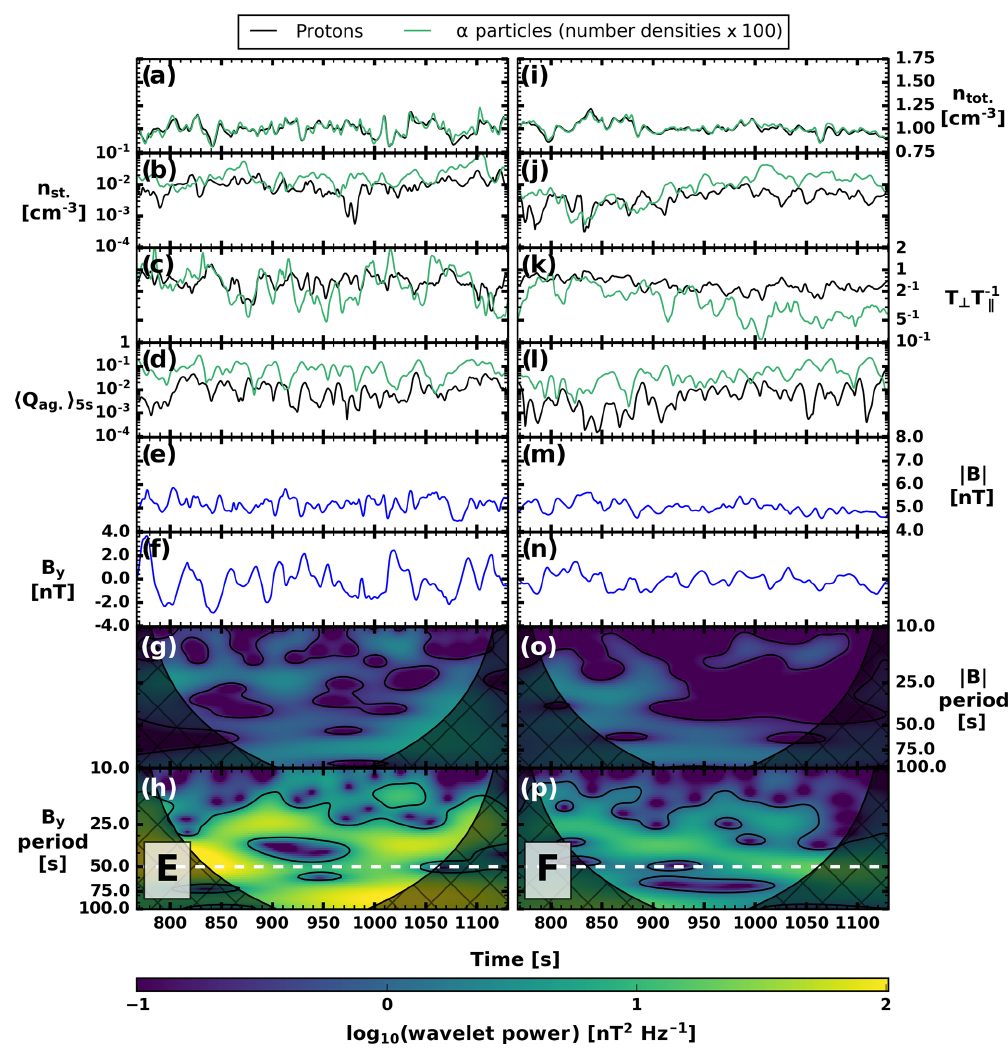
Figure 10. Time series and wavelets at virtual spacecraft positions E (a–h) and F (i–p) in the ULF foreshock. Panels (a–d) and (i–l) show proton (helium) quantities in black (green). (a, i) Total number densities. (b, j) Suprathermal number densities on a logarithmic scale. (a, b, i, and j) The helium number densities have been multiplied by 100. (c, k) Temperature anisotropies. (d, l) Agyrotropy Q ag measured as a 5s running average. (e, m) Magnetic field magnitudes | B | . (f, n) Magnetic field out-of-plane components B y . (g, o) Wavelet power spectra of | B | fluctuations. (h, p) Wavelet power spectra of B y fluctuations. The black contours show the 95% confidence level, and the cross-hatched regions denote the cone of influence. The white dashed lines show the expected frequency of B y fluctuations (see